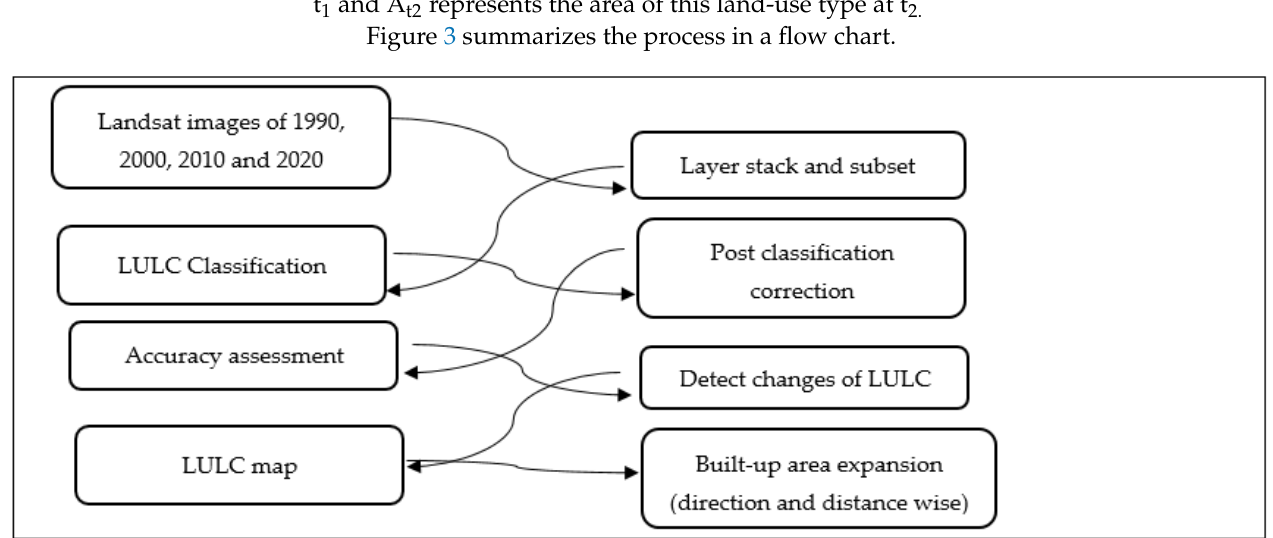
Figure 3. Flow chart of the work.